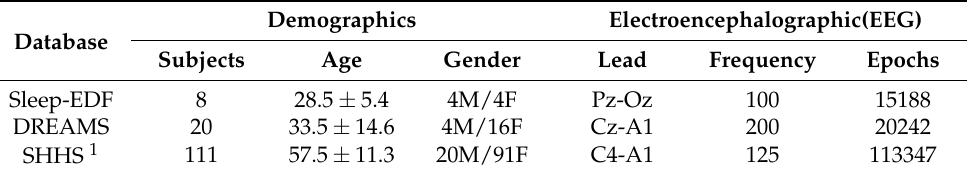
Table 1. Data characteristics (M is for male, and F is for